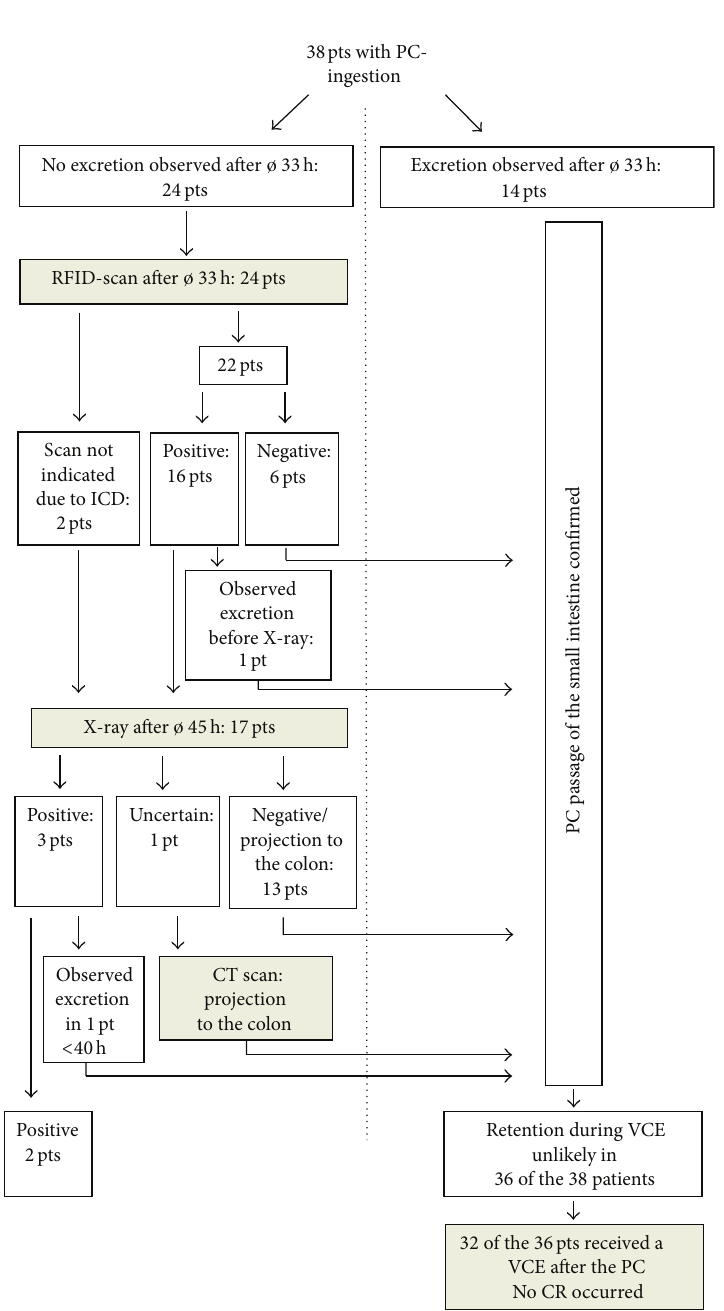
Figure 1: Confirmation of patency of the small intestine by using the patency capsule (PC) : 38 patients (pts) with an indication for VCE and risk factors for capsule retention (CR) received a PC. In 36 patients complete bowel passage could be confirmed using the PC. Sixteen patients observed natural excretion, 14 of whom before any diagnostic steps concerning possible retention. Only 2 patients showed a pathologic PC: one with suspected Crohn’s disease, who gave positive RFID-scans until 13th day past ingestion, and one with a relapse of an endometrium carcinoma. PC: patency capsule, pts: patients, h: hours, VCE: video capsule endoscopy, CR: capsule retention, RFID: radiofrequency identification, and ø: mean